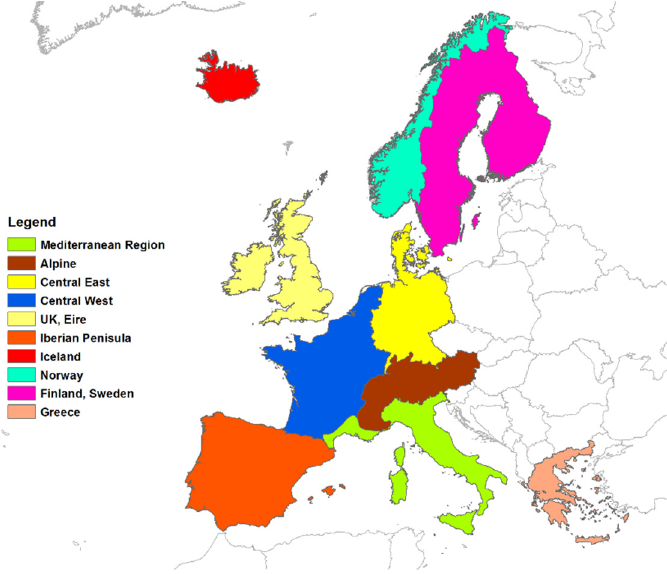
Figure 1. Climatic regions defined in Annex C of EN1991-1-3, based on the results of the ESLRP.